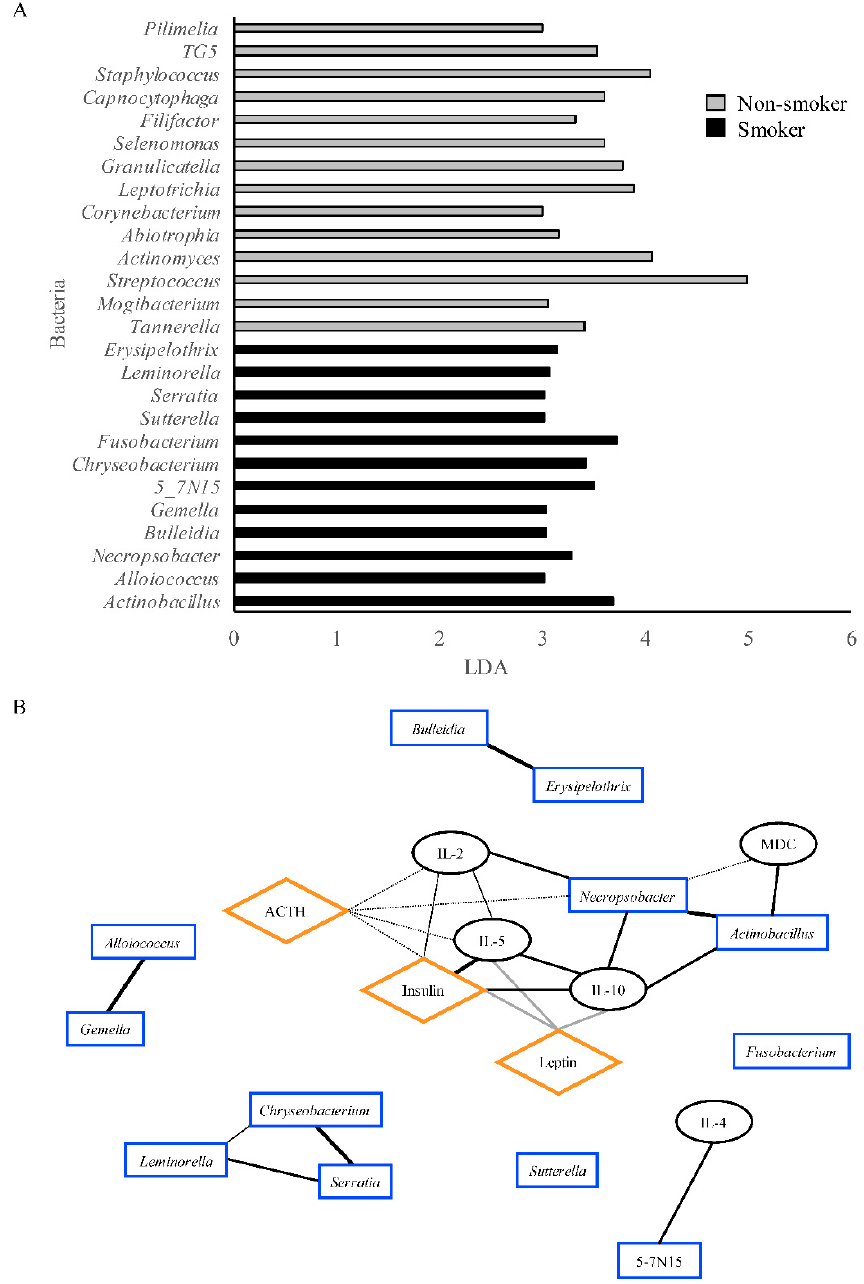
Figure 4. Bacteria associations and correlation network integrating hormones, cytokines, and bacteria variables enriched in the smoker group. ( A ) LEfSe-associated bacteria with nonsmoker and smoker groups, with a p -value < 0.05 and linear discriminant analysis (LDA) >3.0. ( B ) correlation network of bacteria associated by LEfSE in the smoker group, and statistically significant hormones and cytokines. Only significant correlations are shown as determined by qgraph. Gray lines represent negative correlations, whereas black lines represent positive correlations. The line thickness determines the strength of the